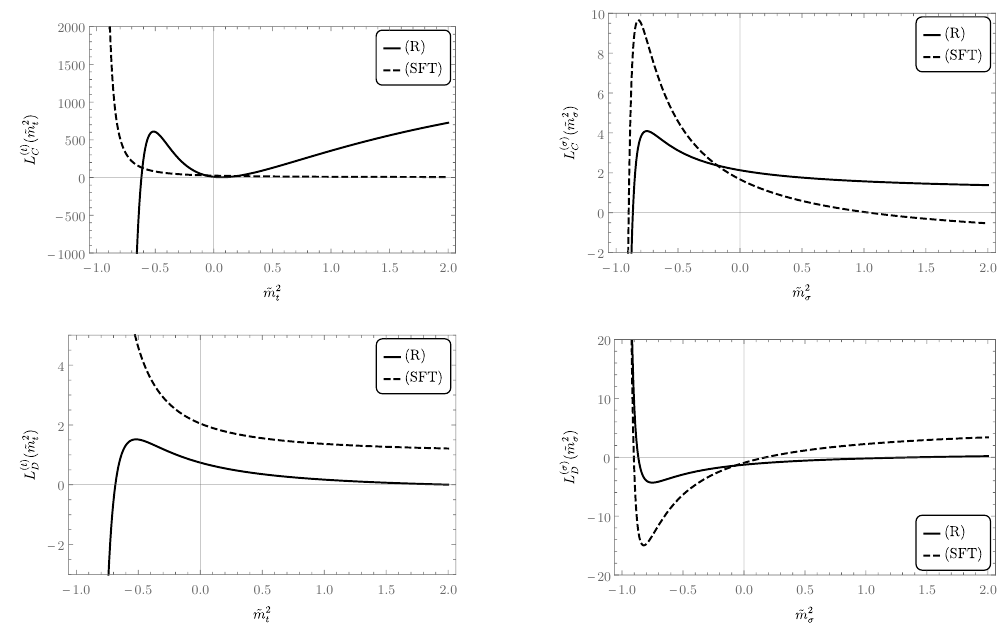
Figure 1 . Behavior of L ( t ) ˜ m 2 . For ω and v we display two cases: (R) v = 0 . 0128638 , ω = − 23 . 1264 and (SFT) v = 0 . 544229 , σ ω = − 0 . 0228639 .